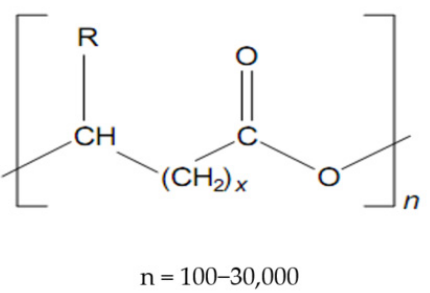
Figure 1. Structure of polyhydroxyalkanoates (PHAs). Table 1. PHAs types.